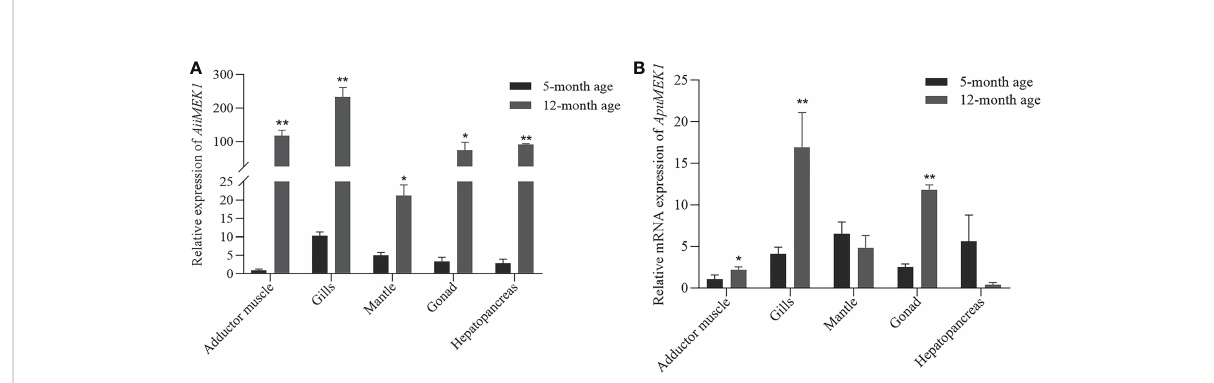
FIGURE 7 Expression of AiiMEK1 (A) and ApuMEK1 (B) at 5th and 12th month (* p < 0.05 and ** p <